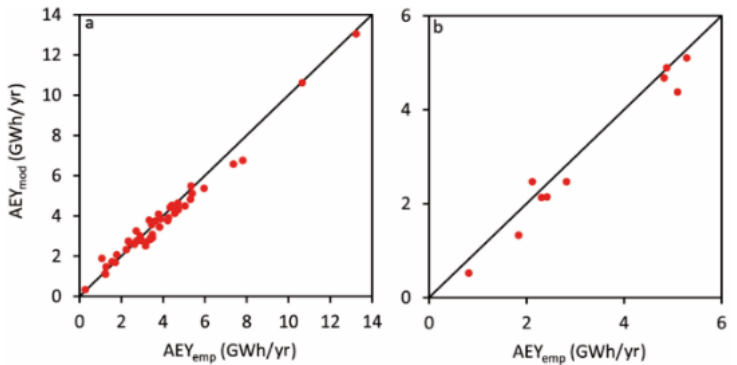
Figure 10. AEY emp plotted against AEY mod for: ( a ) DS1; and ( b ) DS2.